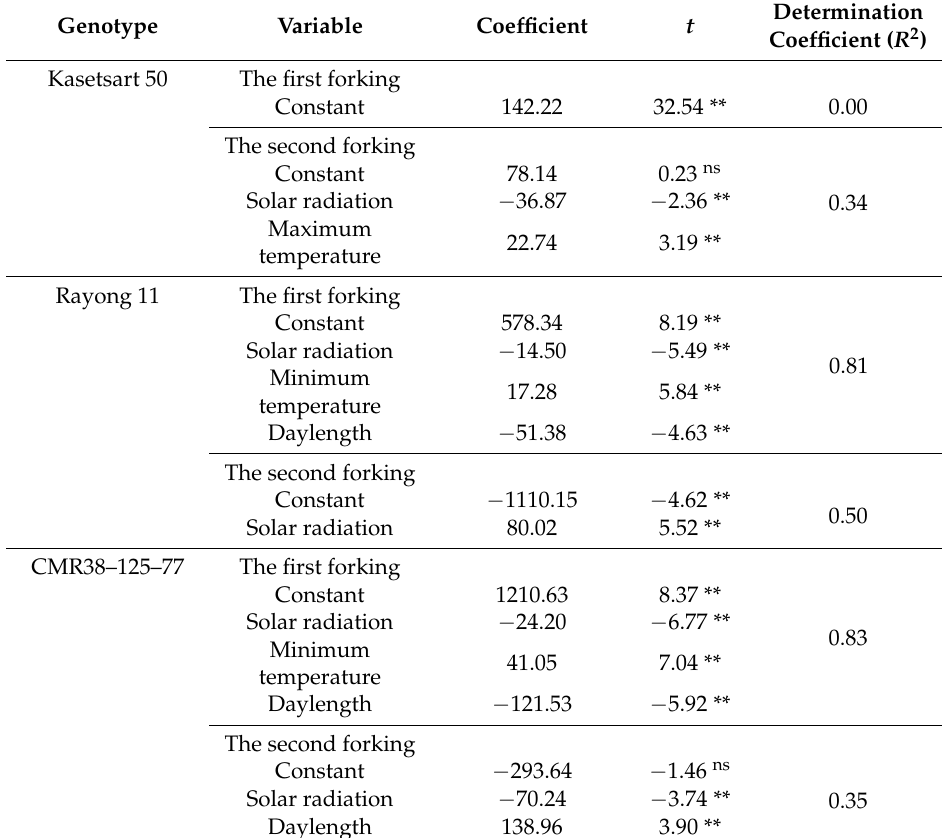
Table 3. Stepwise regression analysis of the forking dates and weather factors for three